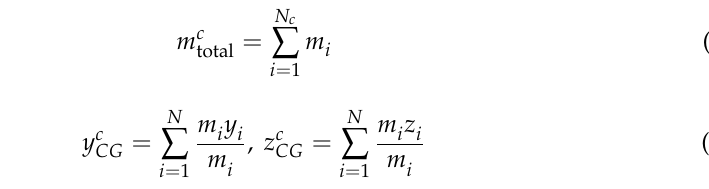
Figure 8. Effect of cable modeling on section offsets, mass, and inertia properties at U6. 2.5. Composition of FE Cross-Sectional Analysis Model The 2D FE discretization process was performed based on the CT scan images com- bined with the digital segmentation task described earlier. Figure 9 shows the FE meshes discretized using 8-node quadrilateral elements (QUAD8) for some of the cross-sections in the blade root region (R2, R5) and blade airfoil region (U2, U7). The number of elements used to discretize the sections are provided in the plots. Generally, 4700–7500 elements were required to model the sections (all 14 stations), except for the innermost sections at the blade root region (R1–R3). The reason for the large numbers of elements in the inboard root regions is the discretization required to cover the thickness of each constituent layer of the spar structure, which consists of alternating fiber angles of (0°/90°/±45°). Up to 274 layers of UD CFRP are used to fabricate the laminated spar in the blade root. Note that the computational burden of modeling and analyzing the sections is significantly de- creased by applying the mass lumping technique. R2